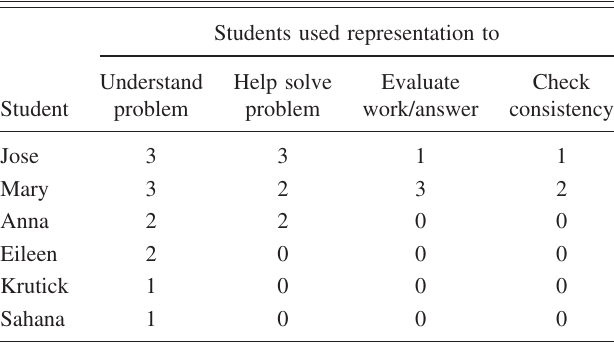
TABLE VI. Number of comments students made.